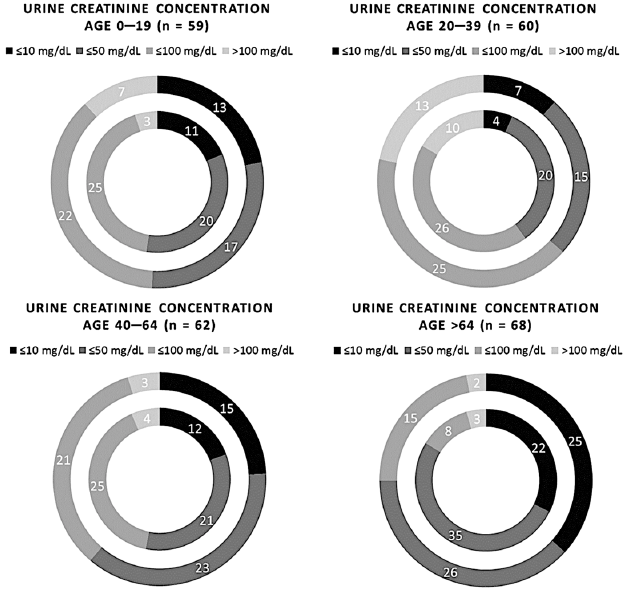
Figure 6. Comparison of 249 samples of creatinuria measured using the semi-quantitative and quantitative methods, redistributed on age. The inner circle represents the Cobas C 501 assay results, and the outer circle indicates the results of the Sysmex UC 3500.